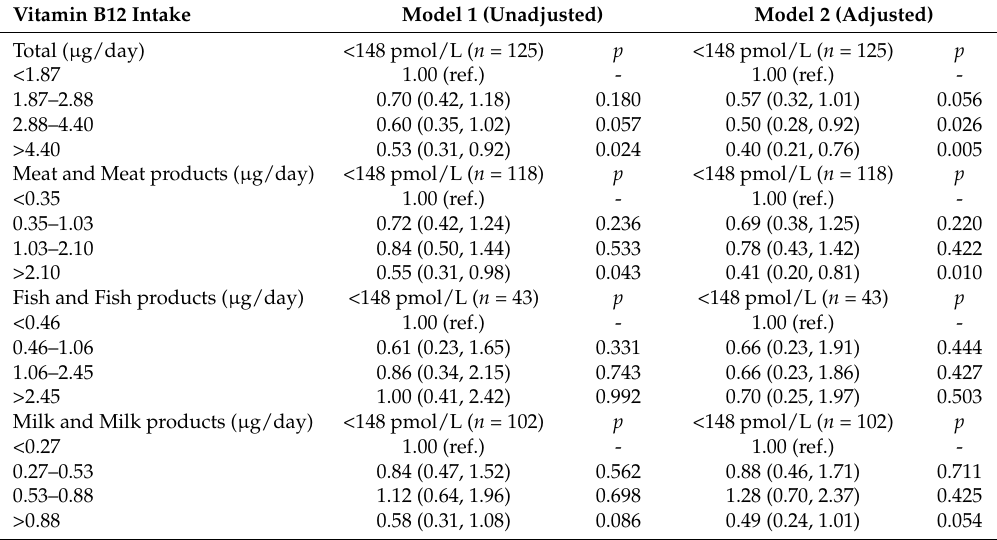
Table 4. Odds ratio (95% CI) of plasma vitamin B12 deficiency according to quartiles of intake of total vitamin B12 and intakes from meat and meat products, from fish and fish products, and from milk and milk products in the Newcastle 85+